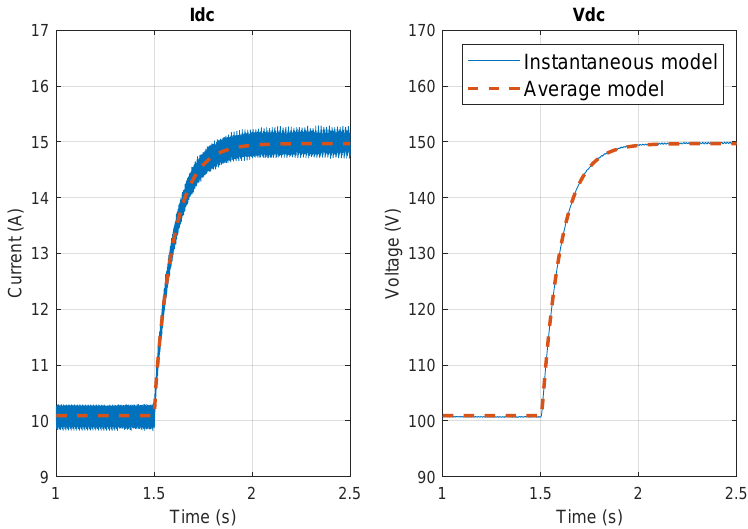
Figure 8. Comparison between the instantaneous model with SVM and the average model in an open loop with the parameters of Table 3 when the voltage reference is increased from 100 V to 150 V on a 10 Ω resistive load with a voltage grid at 110 V.